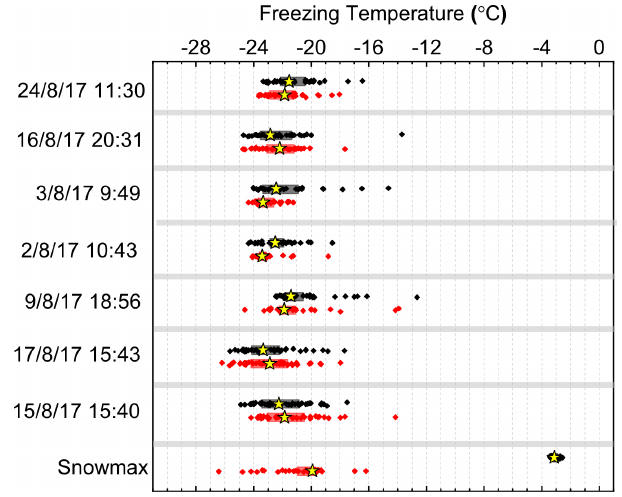
Figure 6. The response of a selection of the aerosol samples to heat, to test for protein-based ice-nucleating material. The date and time correspond to the start of sampling; see Table S1. We also show the heat response of a 0.05wt% Snowmax ® (lyophilized Pseudomonas syringae ), a protein-based ice-nucleating material that is highly sen- sitive to heat from Daily et al. (2022). These heat tests are wet heat tests, where particles were suspended in water and heated in a bath of boiling